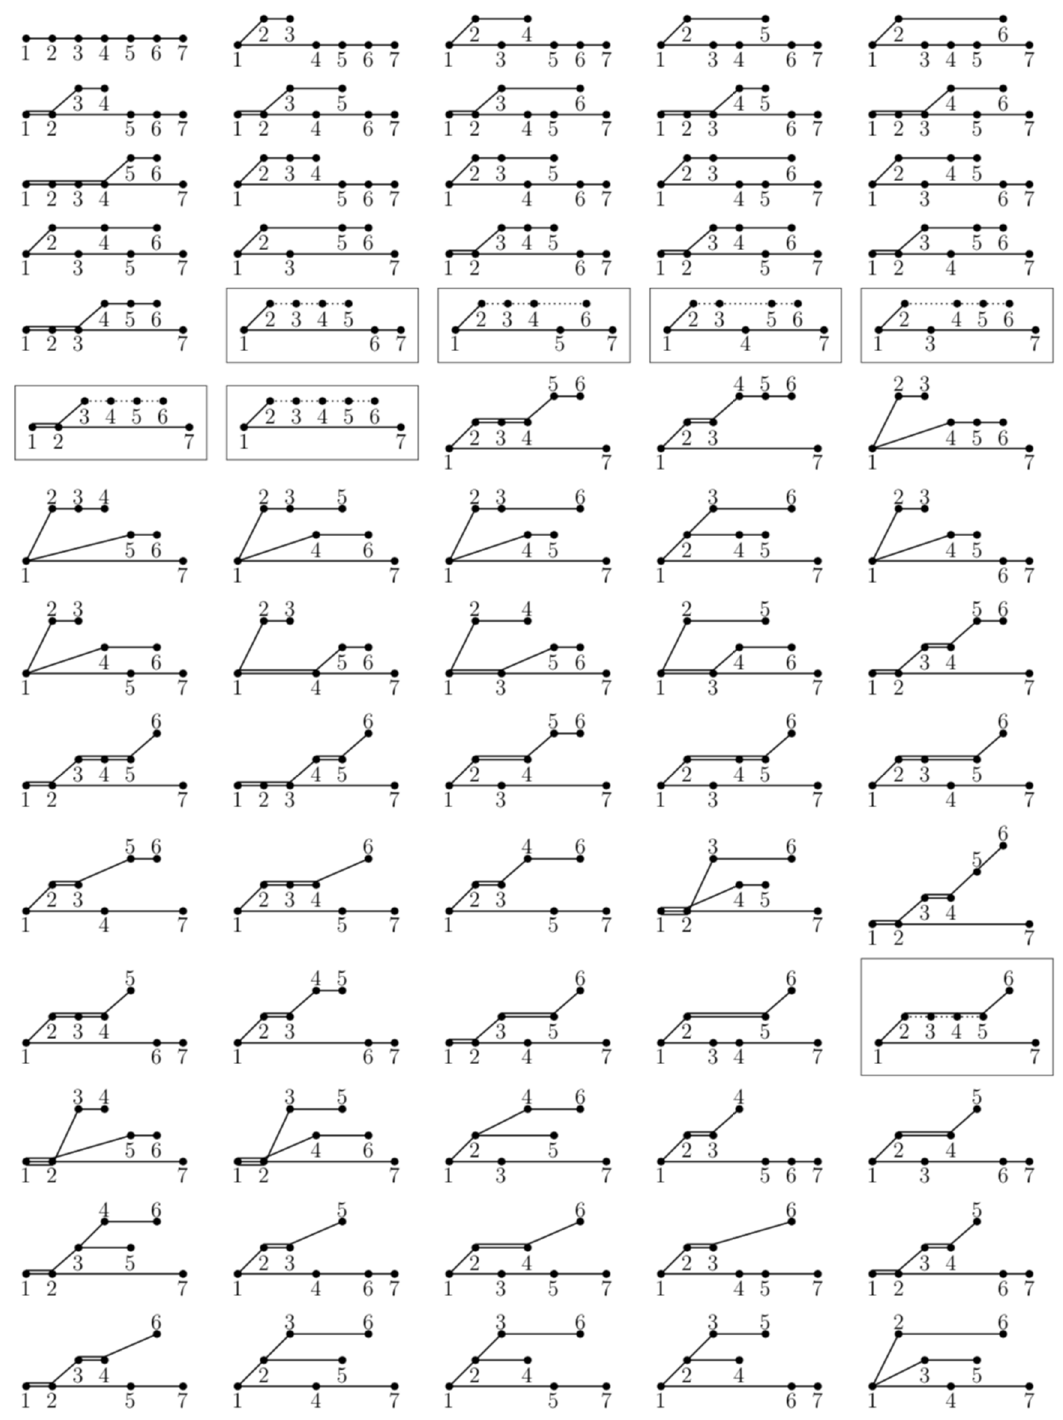
We mark diagrams containing an off-shell numerator with